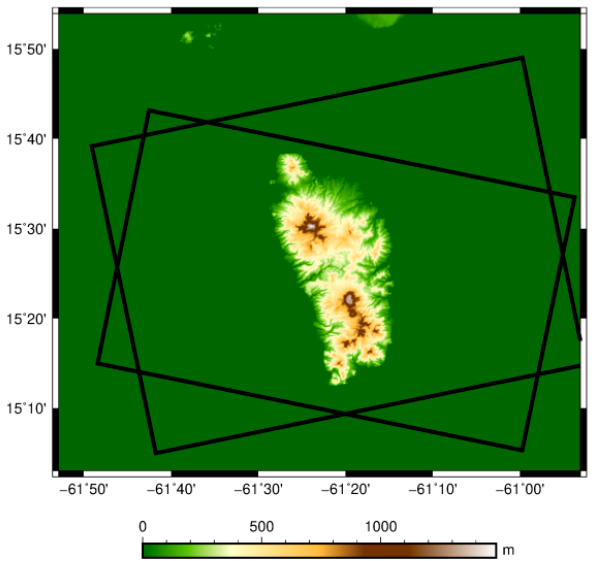
Figure 3. DEM and RADARSAT-2 (RS2) ascending and descending (black rectangles) coverage. The data were preprocessed using MacDonald, Dettwiler and Associates’ Enhanced